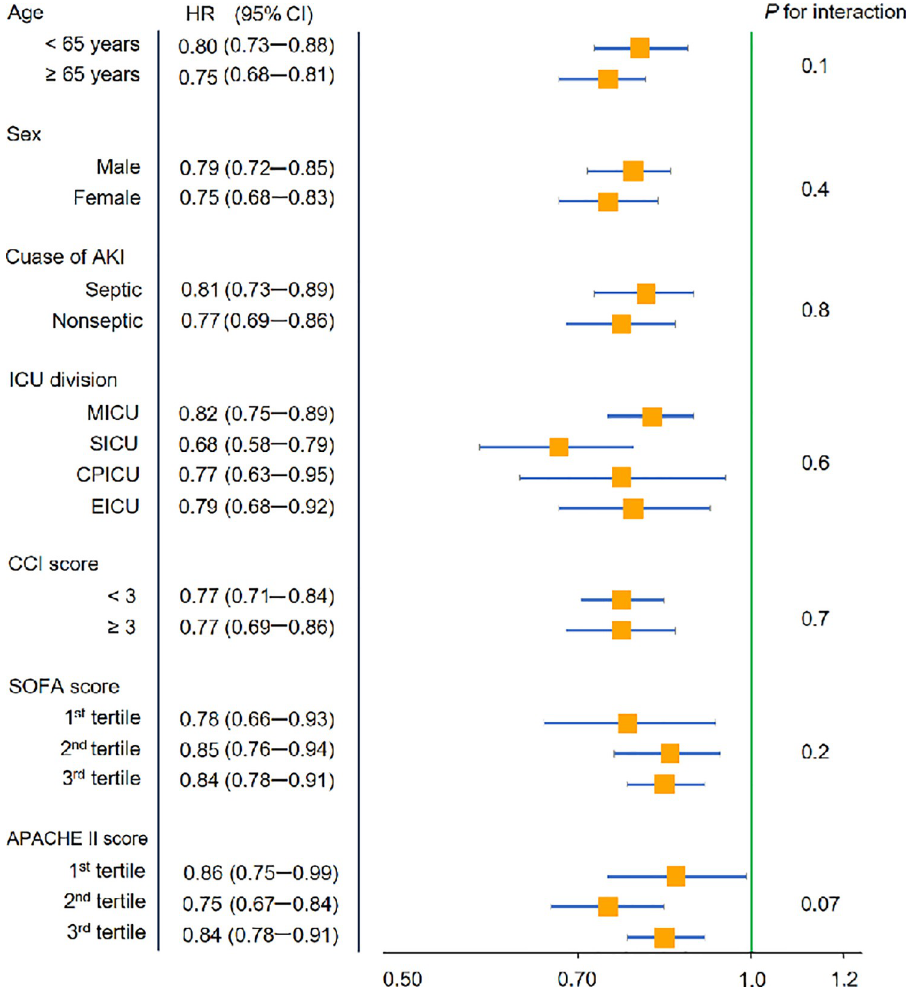
Fig 3. Forest plot of subgroup analysis for the hazard ratio (HR) of all-cause mortality in the consultation group compared with the no consultation group. CI, confidence interval; AKI acute kidney injury; ICU, intensive care unit; MICU, medical intensive care unit; SICU, surgical intensive care unit; CPICU, cardio-pulmonary intensive care unit; EICU, emergency intensive care unit; DICU, disaster intensive care unit for COVID-19 infection; CCI, Charlson comorbidity index; SOFA, sequential organ failure assessment; APACHE, acute physiologic and chronic health evaluation.